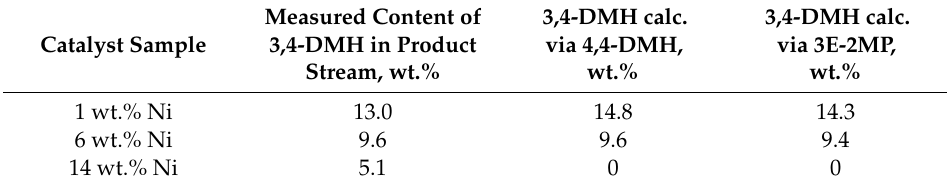
Table 2. Comparison of measured content of 3,4-DMH in product stream with theoretical part of 3,4-DMH generated via carbenium mechanism calculated via the part of 4,4-DMH and 3E-2MP in the product stream, average over 180 h on